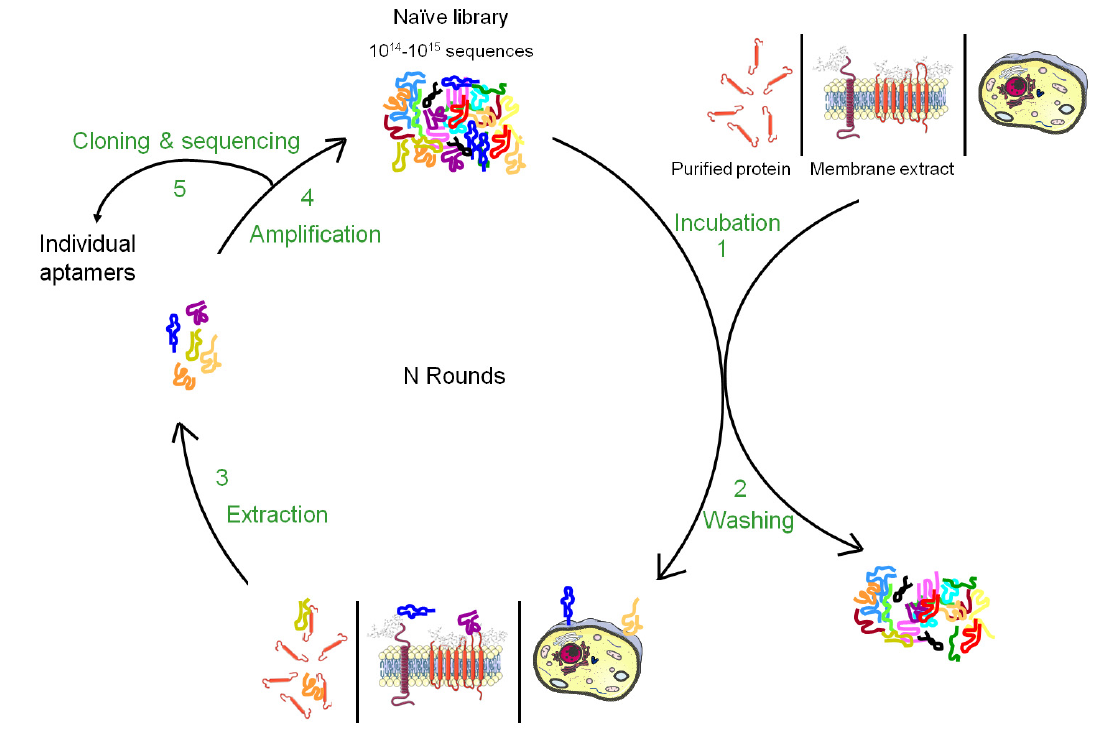
Figure 1. The general principle of the SELEX procedure for a cell surface